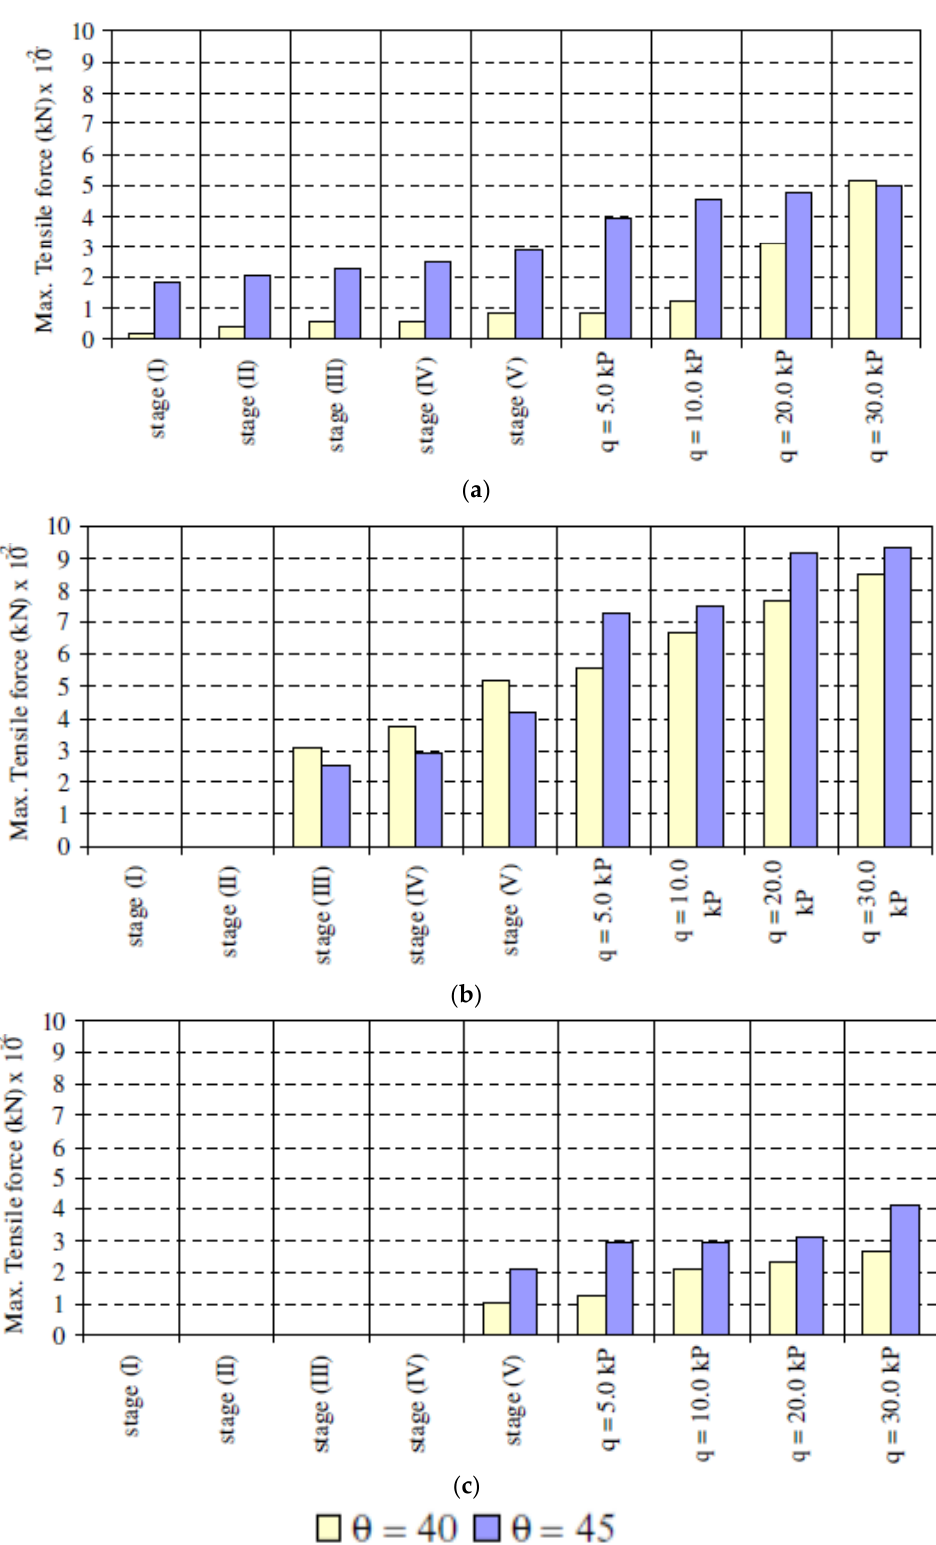
Figure 14. Influence of slope inclination on the maximum tensile force of the footing; ( a ) upper nail; ( b ) middle nail; ( c ) lower nail.